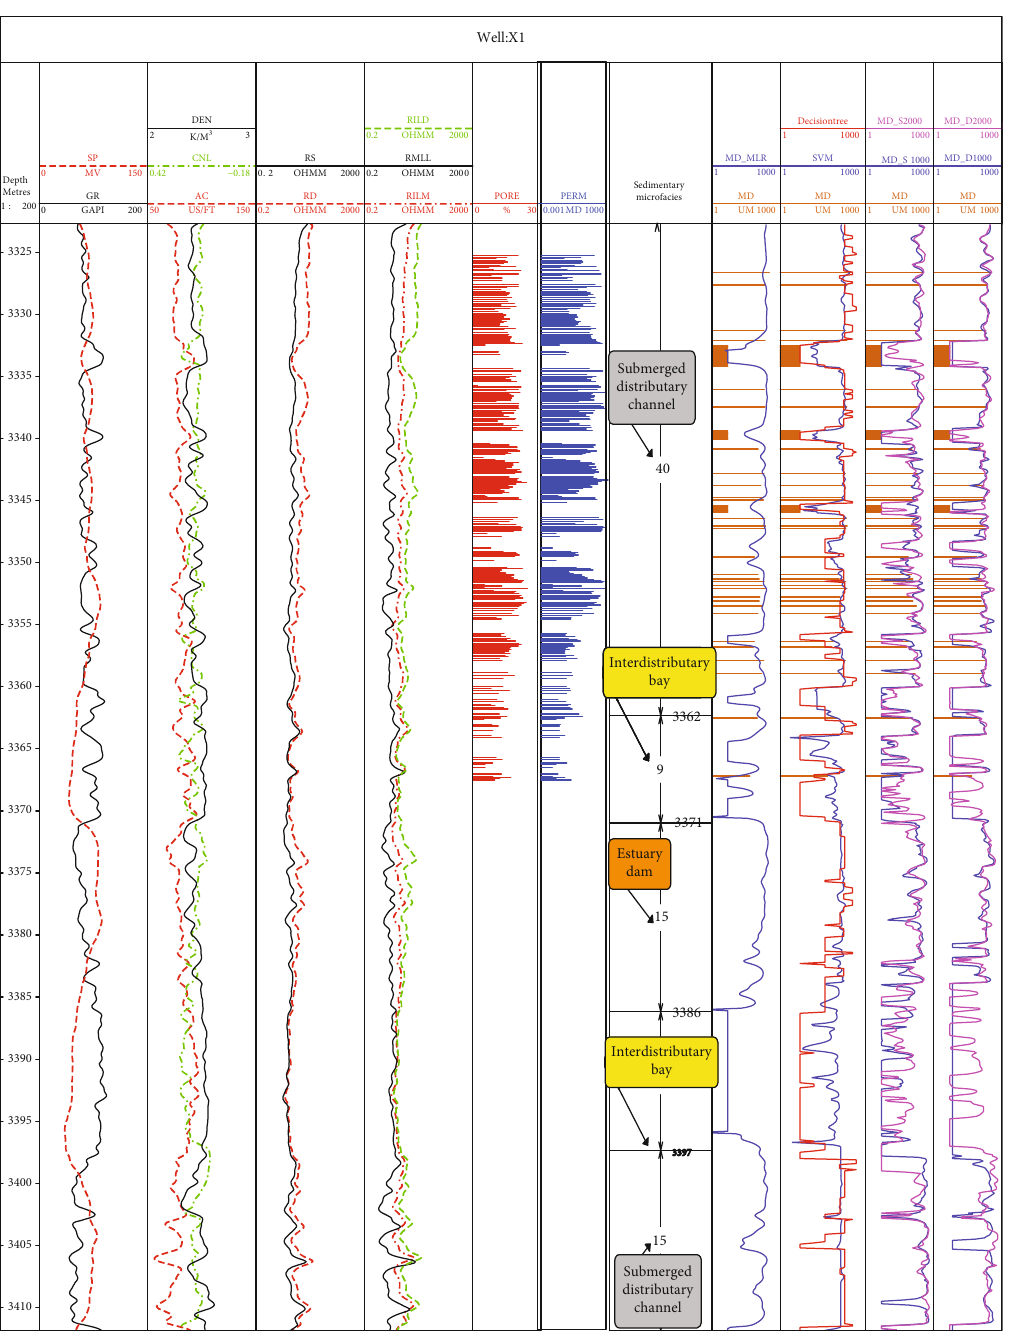
Figure 13: The results of the prediction of the median rock grain size of the conventional logging data in the S